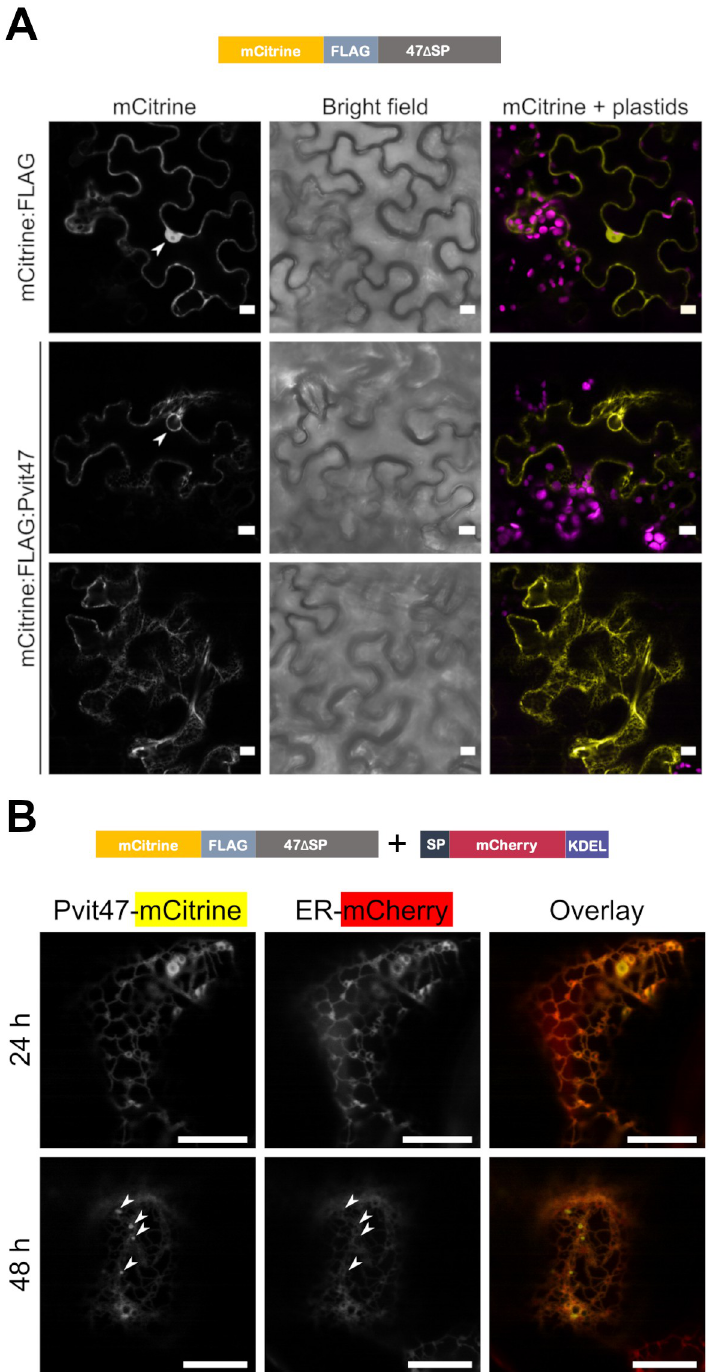
Fig 2. mCitrine-tagged Pvit47 Δ SP localizes to the endoplasmic reticulum (ER). (A) Confocal microscopy images of N . benthamiana leaves transiently expressing mCitrine (top row) and mCitrine-tagged Pvit47 Δ SP (two bottom rows). Arrowheads indicate nuclei. (B) Confocal microscopy images of N . benthamiana leaves transiently co-expressing mCitrine-tagged 47 Δ SP and an ER-targeted version of mCherry. Arrowheads indicate punctate structures that occur at 48 hours post-agroinfiltration (hpa) in mCitrine-tagged Pvit47 Δ SP but not in the ER marker. Images taken at 24- and 48-hpa (top and bottom respectively). KDEL is a four-amino acid ER retention motif. SP: signal peptide. Bars = 10 μ m. The experiment was repeated once with the same results (S3